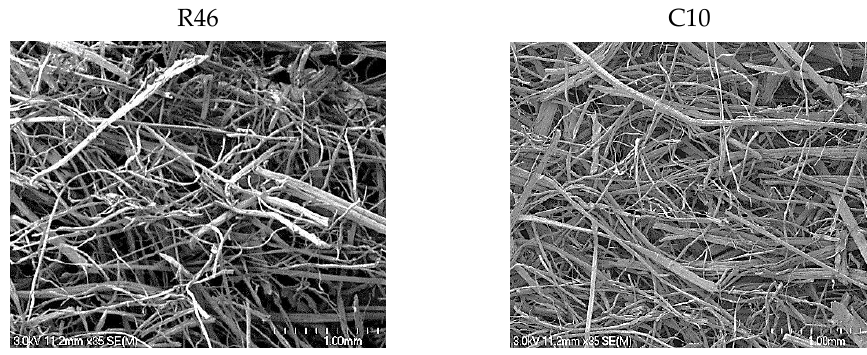
Figure 8. Scanning electron micrographs of fibre mats produced using DSF with different nozzles.